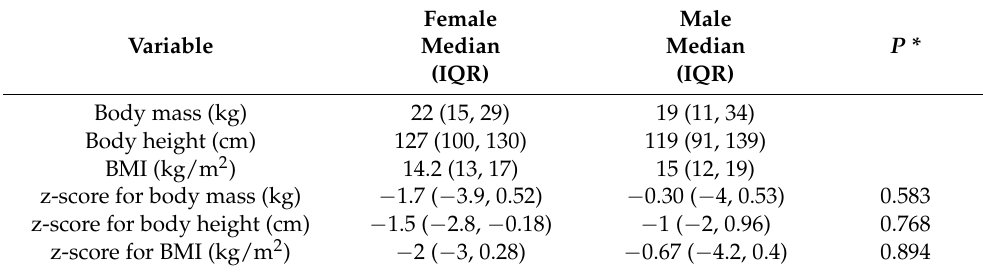
Table 1. Characteristic of the children who underwent PEG tube